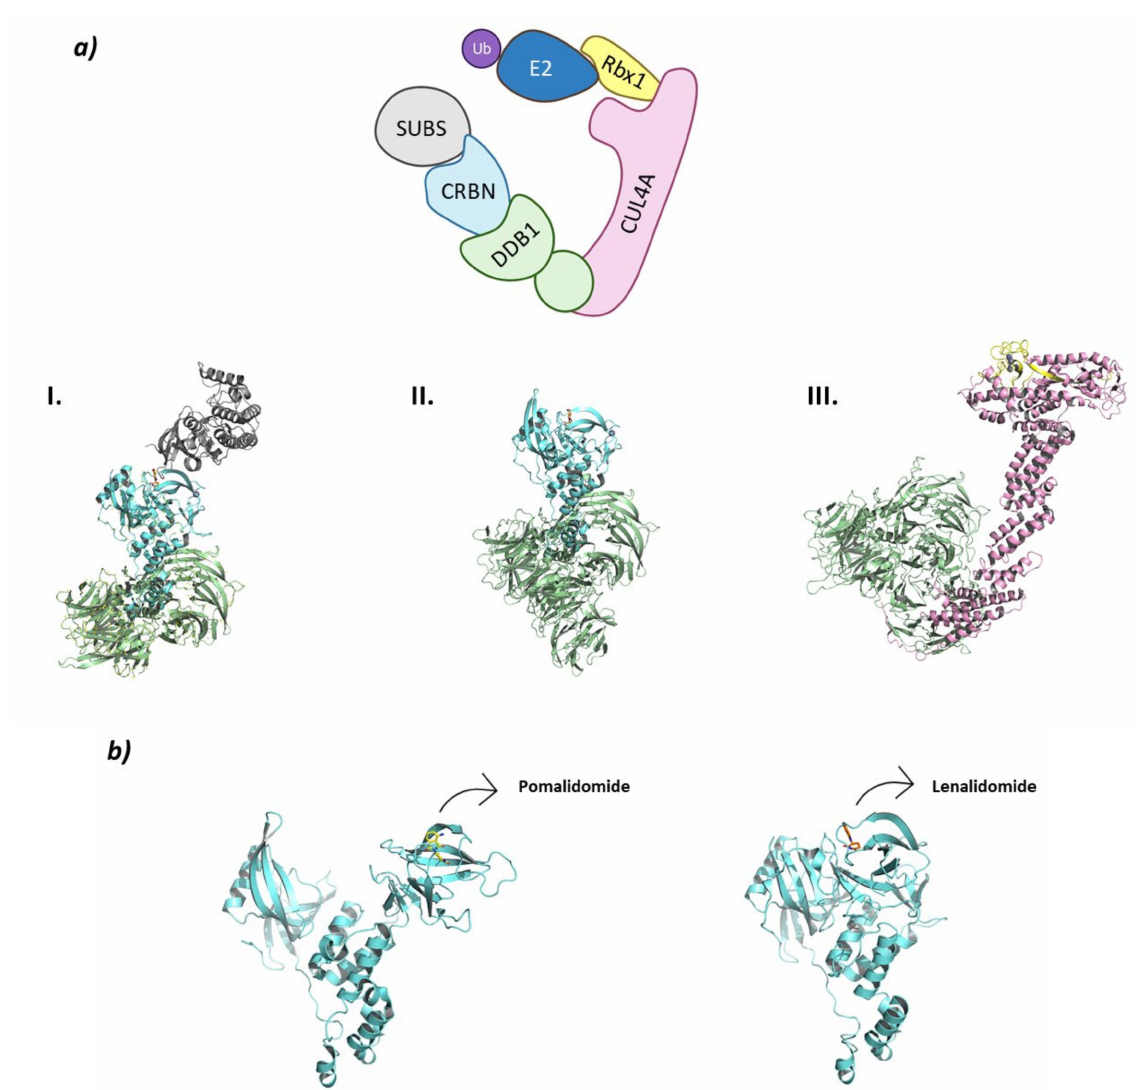
Figure 5. CRL4 CRBN ( a ) Schematic representation of the assembly of the CRL4 CRBN E3 ligase: ubiquitin (Ub) in purple, E2 ligase (E2) in dark blue, Ring Box Protein 1 (Rbx1) in yellow, Cullin-4A (Cul4A) in magenta, adaptor protein DDB1 (DDB1) in green, substrate recognition protein CRBN (CRBN) in light blue, and substrate protein in grey. Protein assembly I is the 3D representation of the system made up of a fragment of DDB1, CRBN bound to lenalidomide (orange sticks) and the substrate protein CK1 α as found in PDB code 5FQD. Protein assembly II is the 3D representation of the full sequence of DDB1, CRBN bound to lenalidomide (orange sticks) as found in PDB code 4CI2. Protein assembly III is the 3D representation of the Rbx1, Cul4A, and DDB1 as found in PDB code 2HYE. ( b ) 3D representation of the two different conformations adopted by CRBN. Open conformation when bound to Ikaros as found in PDB code 6H0F (left), and closed conformation when bound to CK1 α as found in PDB code 5FQD (right). For the sake of clarity, neither the fragment of Ikaros nor the full CK1 α protein bound to CRBN present in the PDB codes are